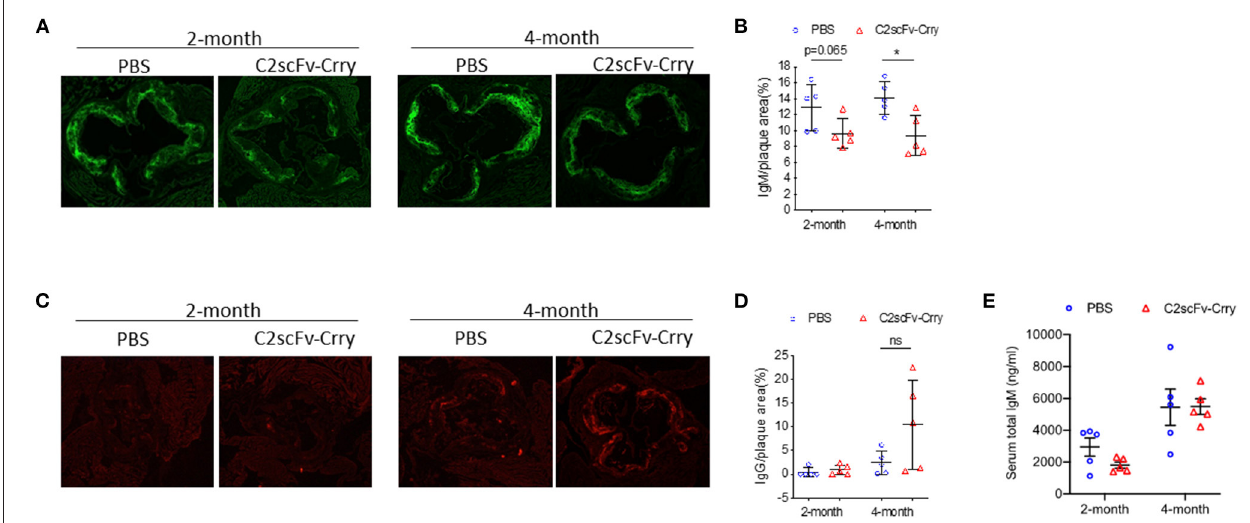
FIGURE 5 | C2scFv-Crry specifically decreases IgM levels in the plaque but not the serum of Apoe − / − mice. (A) Representative total IgM staining in the aortic root of Apoe − / − mice treated with PBS or C2scFv-Crry. (B) Quantification of total IgM positive area in the plaque. (C) Representative total IgG staining in the aortic root of Apoe − / − mice treated with PBS or C2scFv-Crry. (D) Quantification of total IgG positive area in the plaque. (E) Serum total IgM level in Apoe − / − mice (* p < 0.05 using unpaired Student’s t